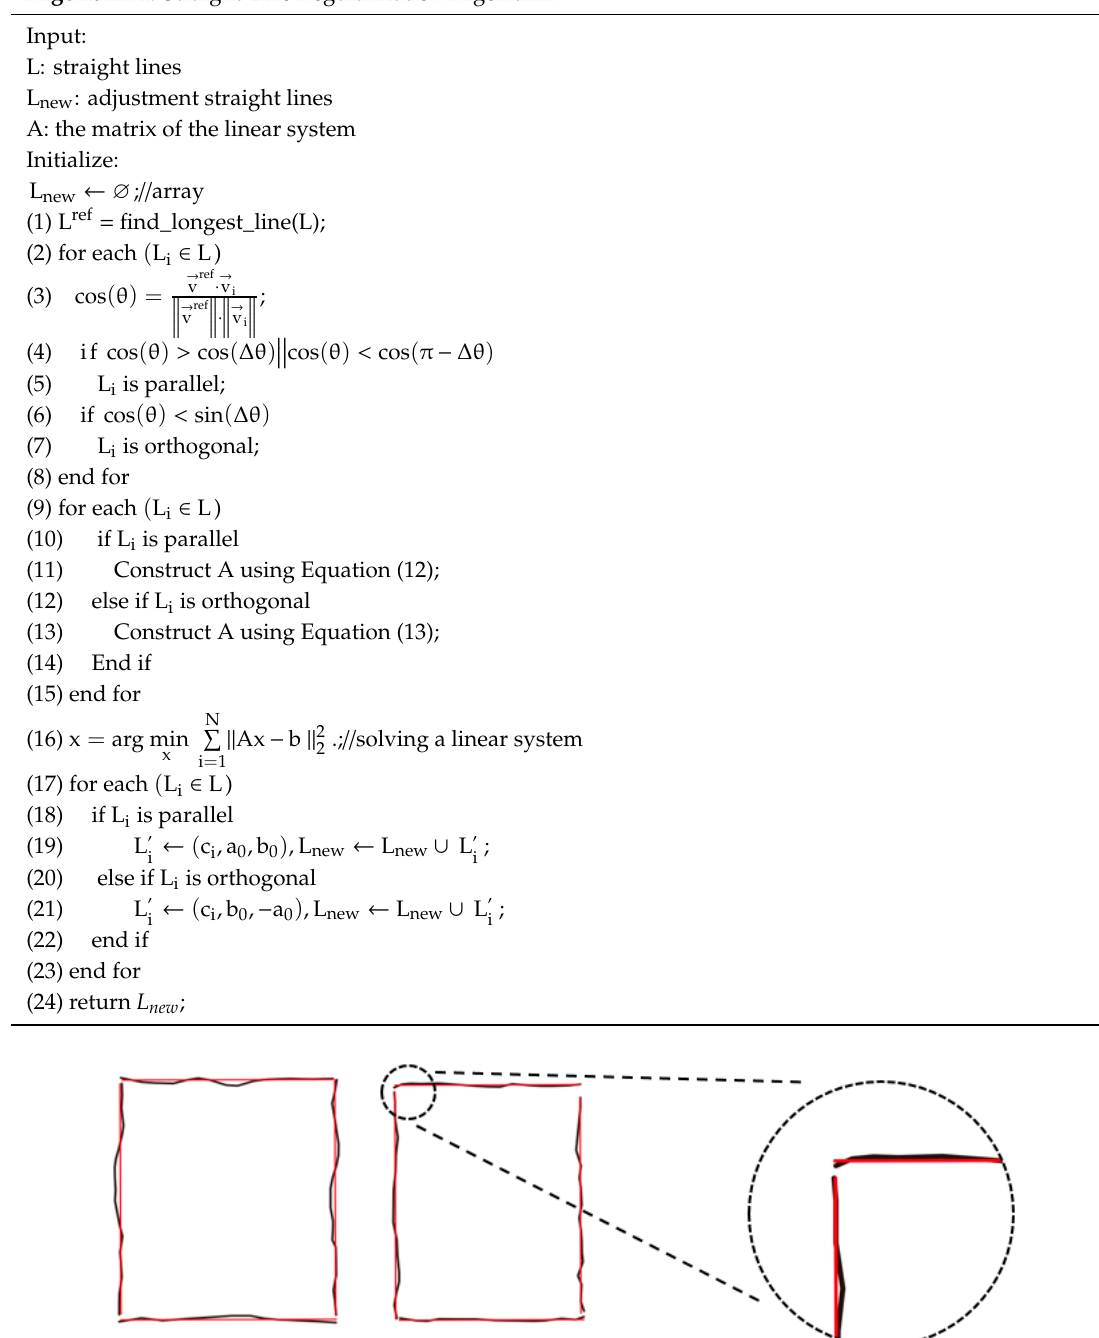
Algorithm 1. Straight Line Regularization Algorithm.